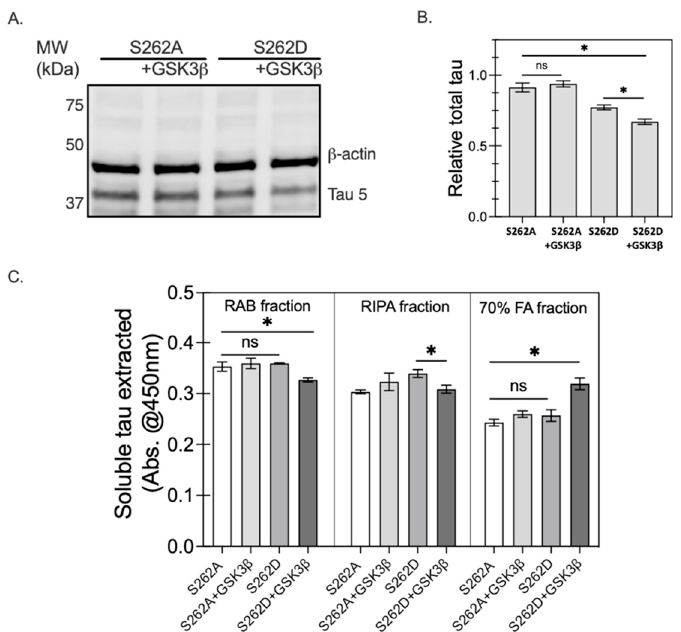
Figure 10. Insoluble tau levels are highest for cells co-expressing S262D and GSK3 β . ( A ) CHO cells transfected with the tau S262A or S262D variant with or without co-transfection of GSK3 β were lysed and the soluble portion of cell lysates were immunoblotted with anti-total tau antibody, Tau-5, and endogenous control protein, β -actin, and a representative Western is shown. ( B ) The ratio of Tau-5 to β -actin was analyzed for the different cell lysates. Total protein loaded was equivalent, though similar β -actin levels were present in each sample. Relative soluble tau was determined by quantifying Tau5+ band intensity relative to β -actin to quantify the soluble tau content (* represents p < 0.05 between two different means, n = 3, with error shown as the SEM). ( C ) Crude cell lysates from different groups were sequentially extracted by RAB, RIPA, and 70% FA, as indicated, and evaluated by total tau ELISA assay. A significant decrease was observed in soluble tau levels in RAB and RIPA fractions and an increase in the 70% FA fraction for cell lysates from S262D with GSK3 β co-expression as compared to the other three cell lysates. Cell lysates for tau S262A without (unshaded) or with (light gray) co-transfection of GSK3 β or S262D variant without (medium gray) or with (dark gray) co-transfection of GSK3 β (* represents p < 0.05 between means, n = 3, with error shown as the SEM; ns = not significant).